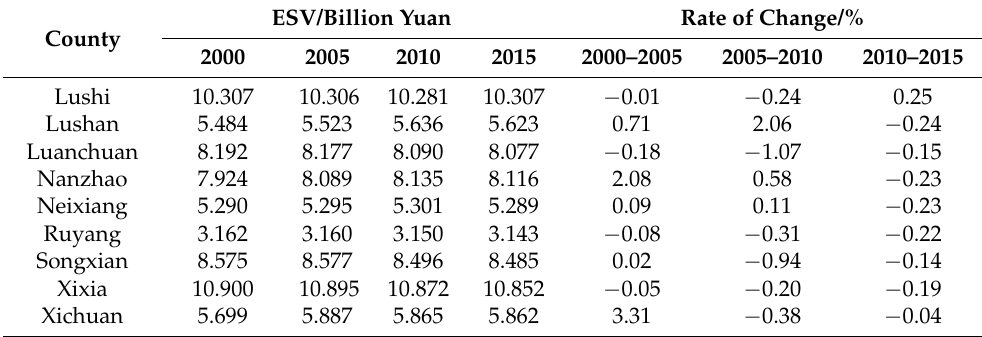
Figure 2. Spatial distribution of the ESV in different periods at the grid scale in the Funiu Moun- tain area. Table 5. ESV and ESV change rate in the Funiu Mountain area from 2000 to